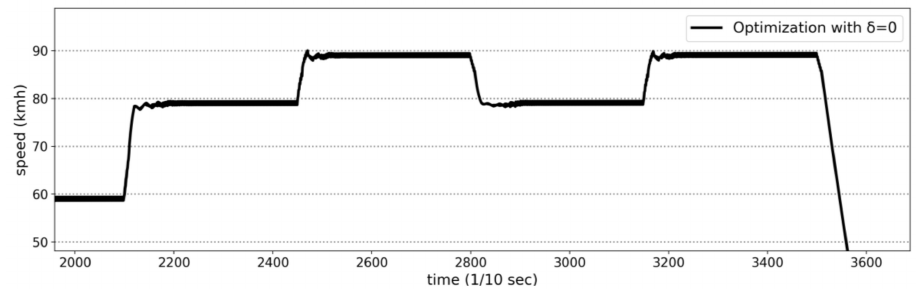
Figure 7. Detail of some step responses disabling the decay ratio d ( δ = 0), clearly showing the oscillations in the controller